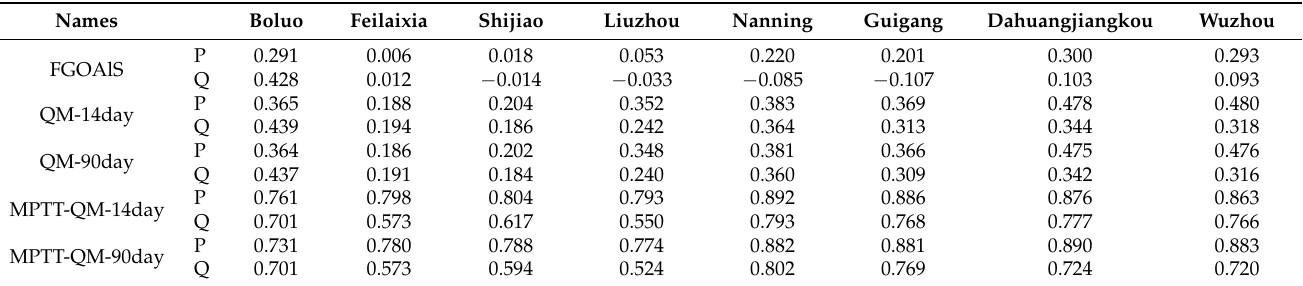
Figure 8. Spatial distribution of daily correlation coefficients (R) of hydrological stations in the PRB: ( a – f ) represent the IMERG, FGOALS, QM-14day, QM-90day, MPTT-QM-14day, and MPTT-QM-90day, respectively. Table 4. Summary of performance based on the monthly KGE coefficients of hydrological stations in the PRB for the FGOALS, QM-14day, QM-90day, MPTT-QM-14day, and MPTT-QM-90day. For a hydrological station, P represents the KGE coefficient of model-simulated area rainfall of the upstream basin compared with IMERG. Q . represents the KGE coefficient of model-simulated runoff compared with the IMERG-DRIVE-simulated